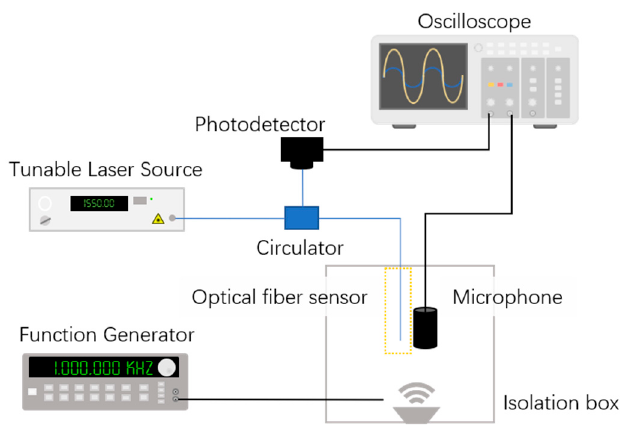
Figure 5. Experimental setup for the acoustic characterization.